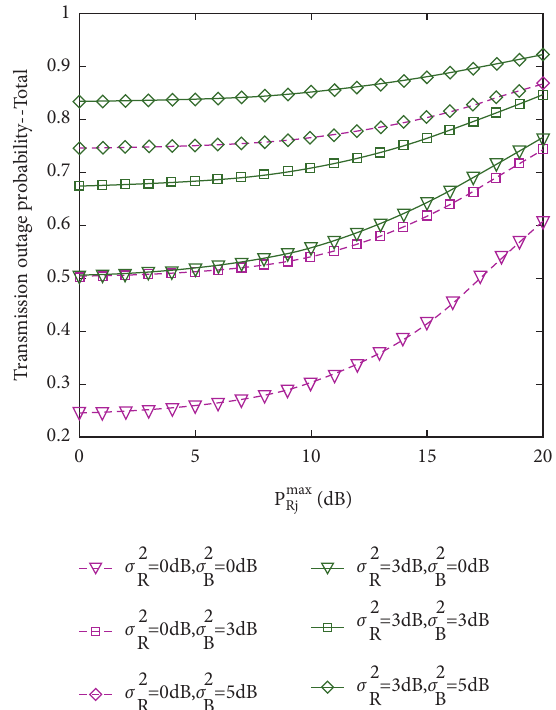
Figure 18: Total transmission outage probability versus P max different value of σ 2 R and σ 2 B , where P R � 3, and ϕ � 0 . R � 1 . 5, N R